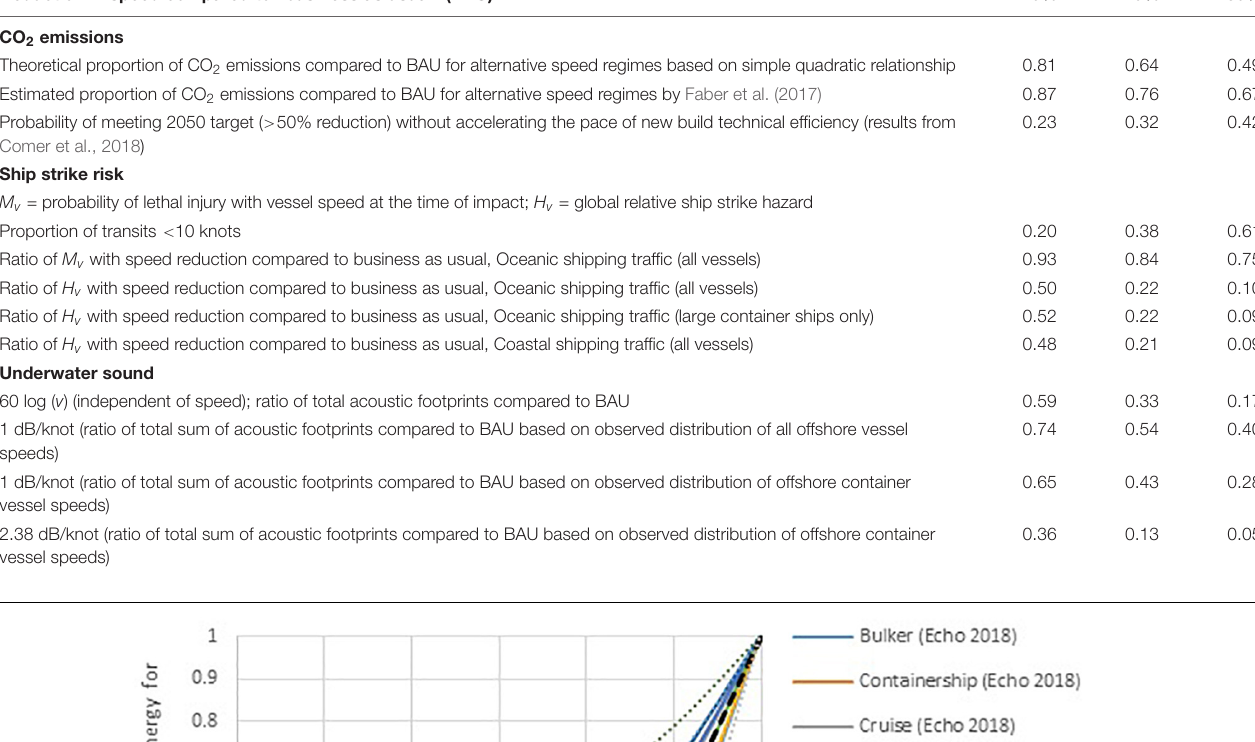
TABLE 1 | Changes in parameters for scenarios of 10–30% speed reductions across the global fleet adjusted for the same total cargo carried. Reduction in speed compared to “business as usual” (BAU) 10%